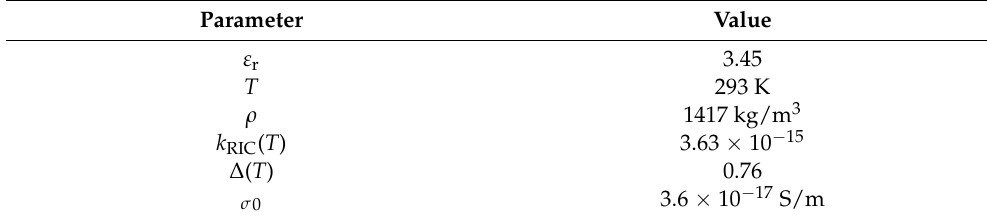
Table 1. Related parameter settings in simulation.